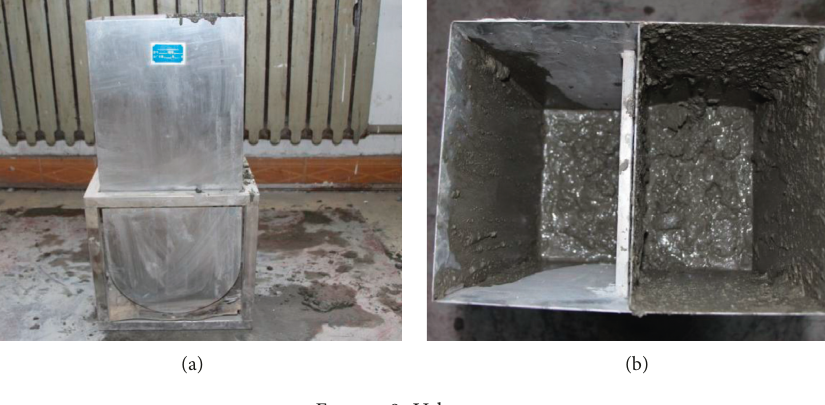
Figure 8: U-box test.